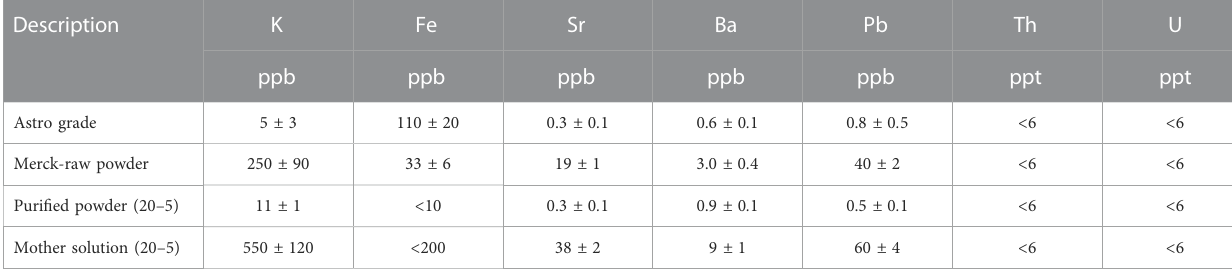
TABLE1RepresentativeICP-MSresultsofrawandpuri fi edpowdersvs.Astro-gradepowder ’ spurity.Uncertaintiesaregivenat90%C.L,andupperlimitsaregiven at 95% C.L.